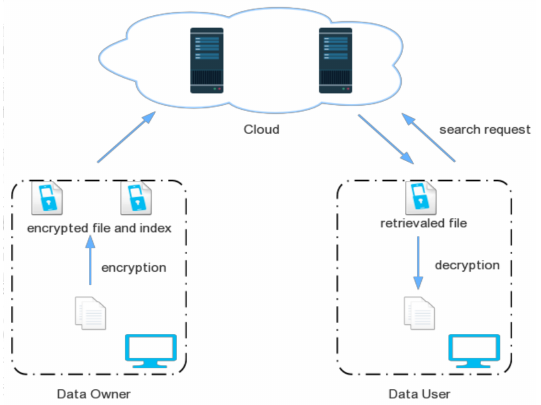
Figure 1. Traditional Encrypted Search